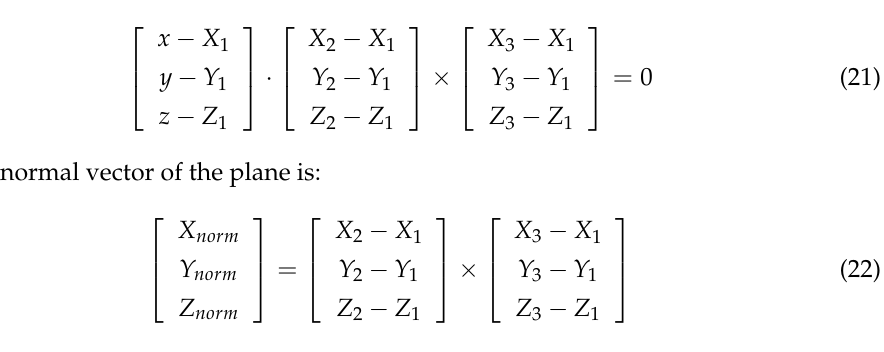
The function of another plane is determined by 3 points ( X i , Y i , Z i ) , i = 1, 2, 3 and the plane equation below.